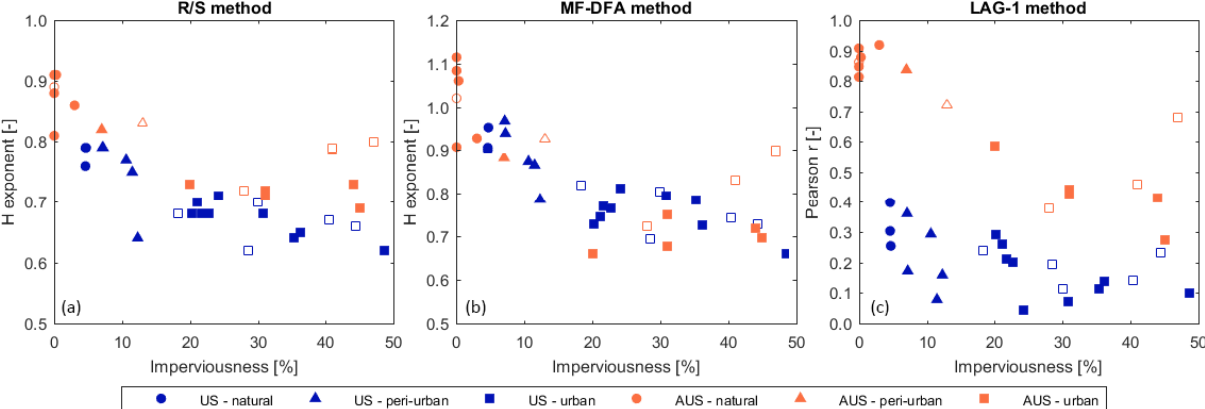
Figure 1. Relationship between the percentage of catchment impervious area and the H exponent of the streamflow series estimated with the R/S method (a) and the MF-DFA method (b) , and lag-1 Pearson’s autocorrelation coefficient ( r ) (c) for catchments in the USA and Australia. Time series with gaps longer than 200 consecutive days have empty